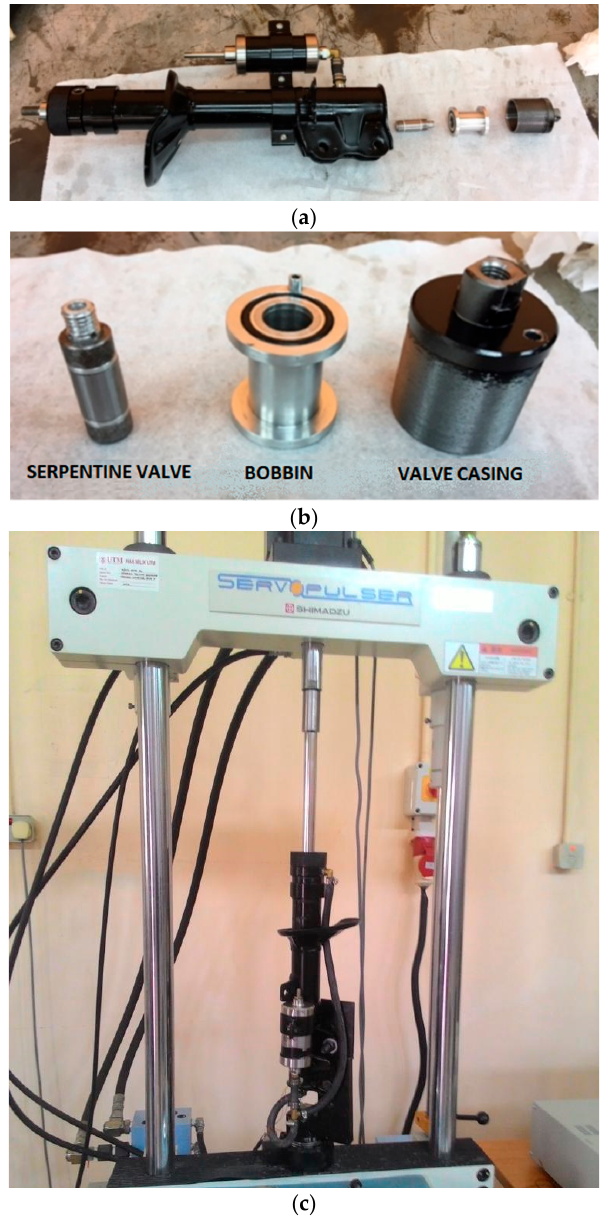
Figure 13. Experimental setup for dynamic characterization of MR damper: ( a ) Breakdown of MR damper, ( b ) Breakdown of MR valve, ( c ) Installation of MR damper in the dynamic machine.